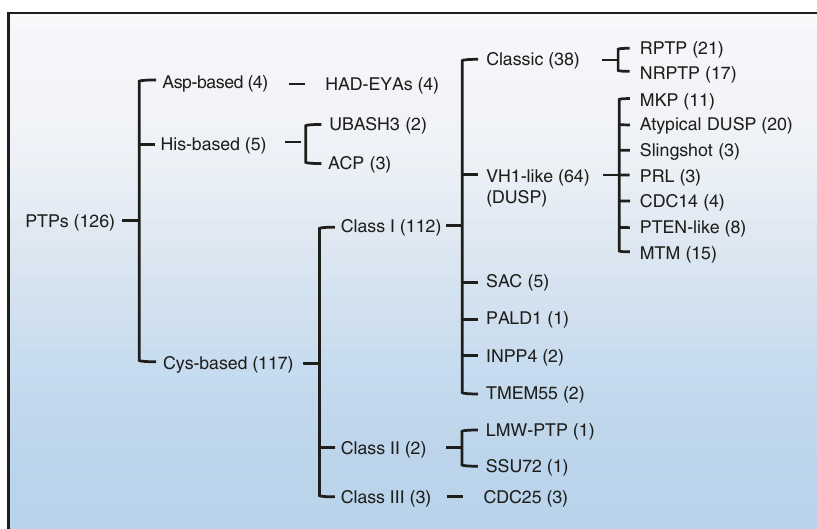
Fig. 2 Classi fi cation of PTPs in the human genome. There are ~126 PTPs in the human genome. These PTPs are classi fi ed into three major groups based on their nucleophilic catalytic residue (Cys, Asp, or His) and topology. The numbers in parentheses indicate the members of PTPs included in each group. Only 9 PTPs are Asp- or His-based; the remaining 117 are Cys-based PTPs consisting of classes I, II, and III. Class I PTPs are further divided into six groups based on domain architecture and the degree of homology between catalytic domains. Classes II and III contain only two and three members, respectively. EYA eyes absent, UBASH3 ubiquitin-associated and SH3 domain-containing protein, ACP acid phosphatase, VH1 Vaccinia virus H1 gene product, DUSP dual-speci fi city phosphatase, RPTP receptor-like protein tyrosine phosphatase, NRPTP nonreceptor protein tyrosine phosphatase; MKP mitogen-activated protein kinase phosphatase, PRL phosphatase of regenerating liver, CDC cell division cycle, PTEN phosphatase and tensin homolog, MTM myotubularin, SAC sac phosphoinositide phosphatase, PALD1 phosphatase domain-containing paladin 1, INPP4 inositol polyphosphate-4-phosphatase, LMW low molecular weight, SSU72 RNA polymerase II subunit A C-terminal domain phosphatase